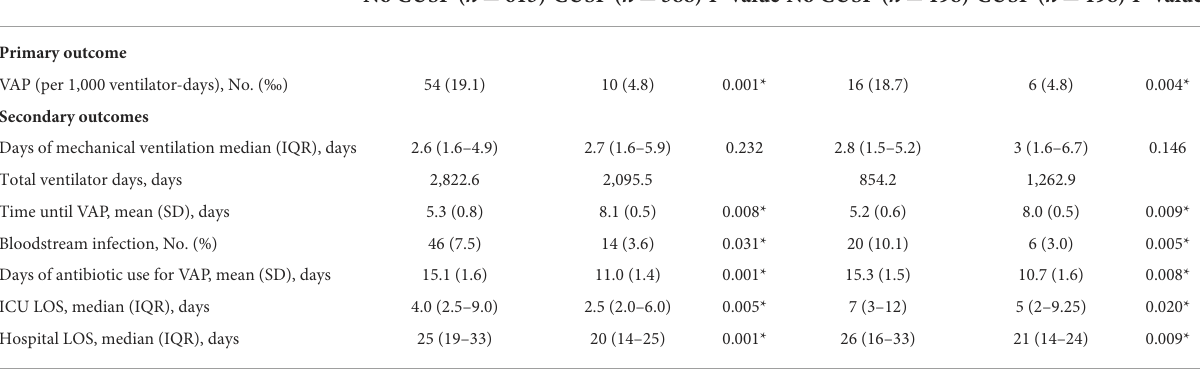
TABLE 5 Primary and secondary outcomes, based on the study group in the SICU setting. Variables Before propensity matching